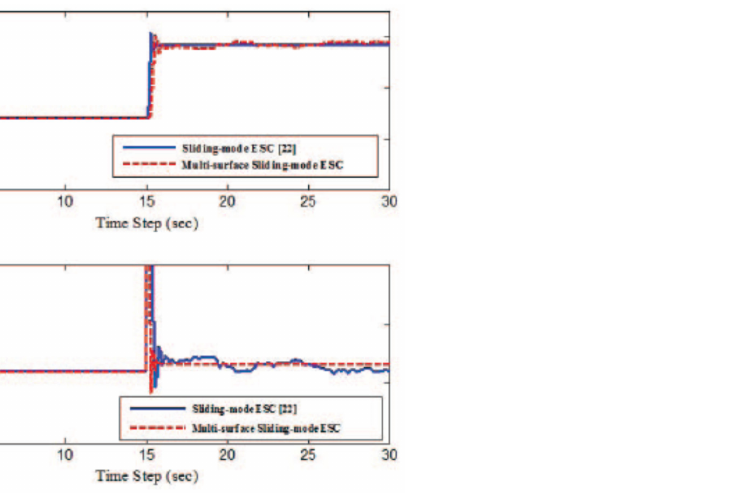
Figure 27. Step response for the alternator when applying the multi-surface algorithm “Adapted from [26]”.